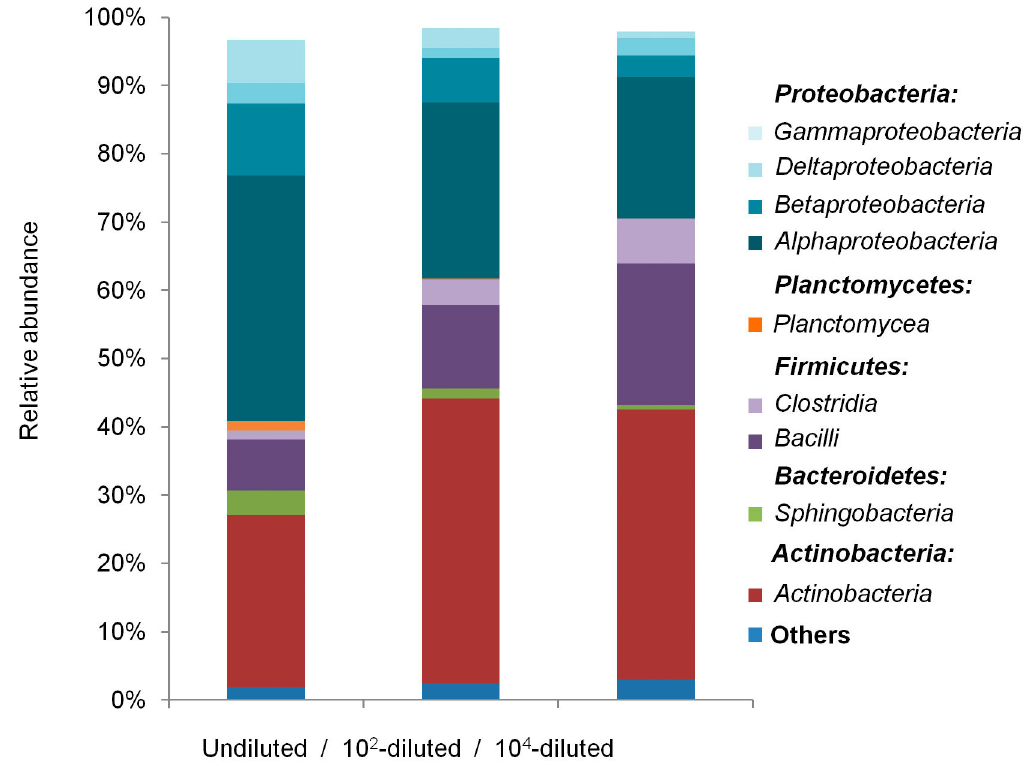
Figure 5. Phylogenetic community composition of microcosms. Relative abundance (%) of detected classes.